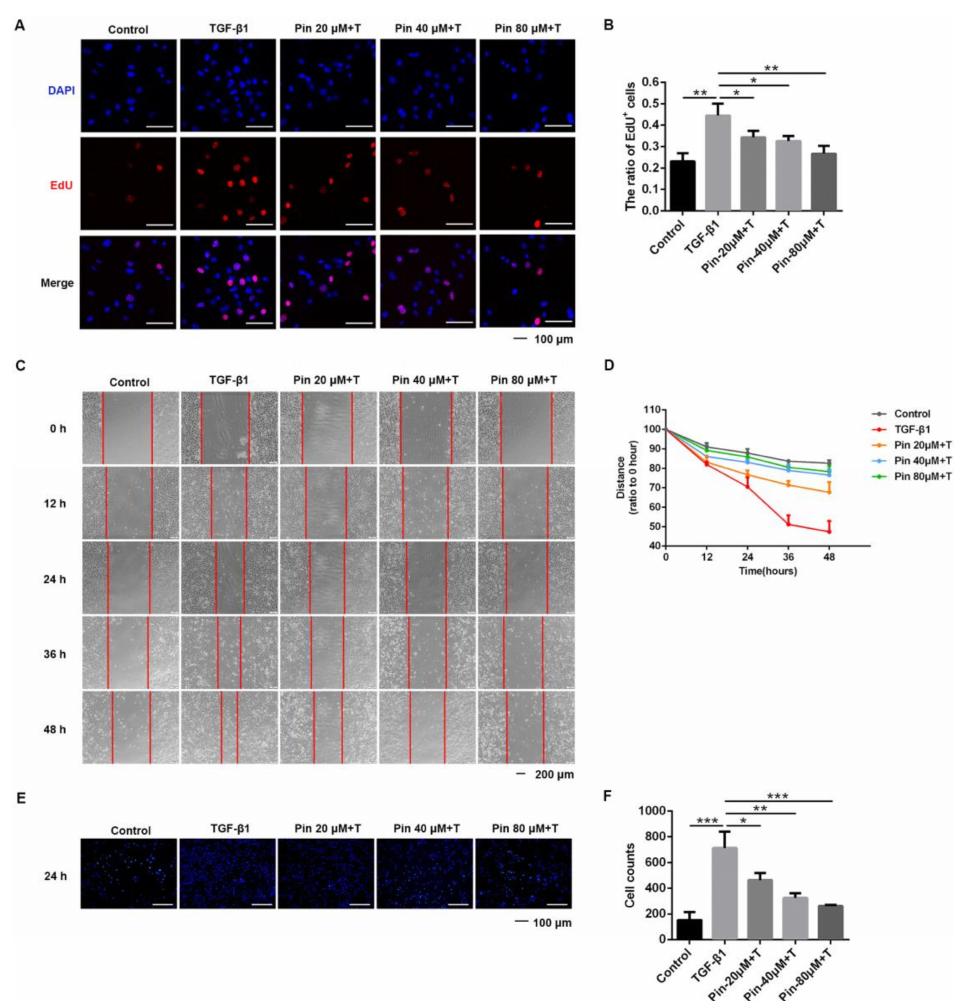
Figure 1. Pinocembrin suppresses TGF- β 1-induced proliferation and migration of mouse primary dermal